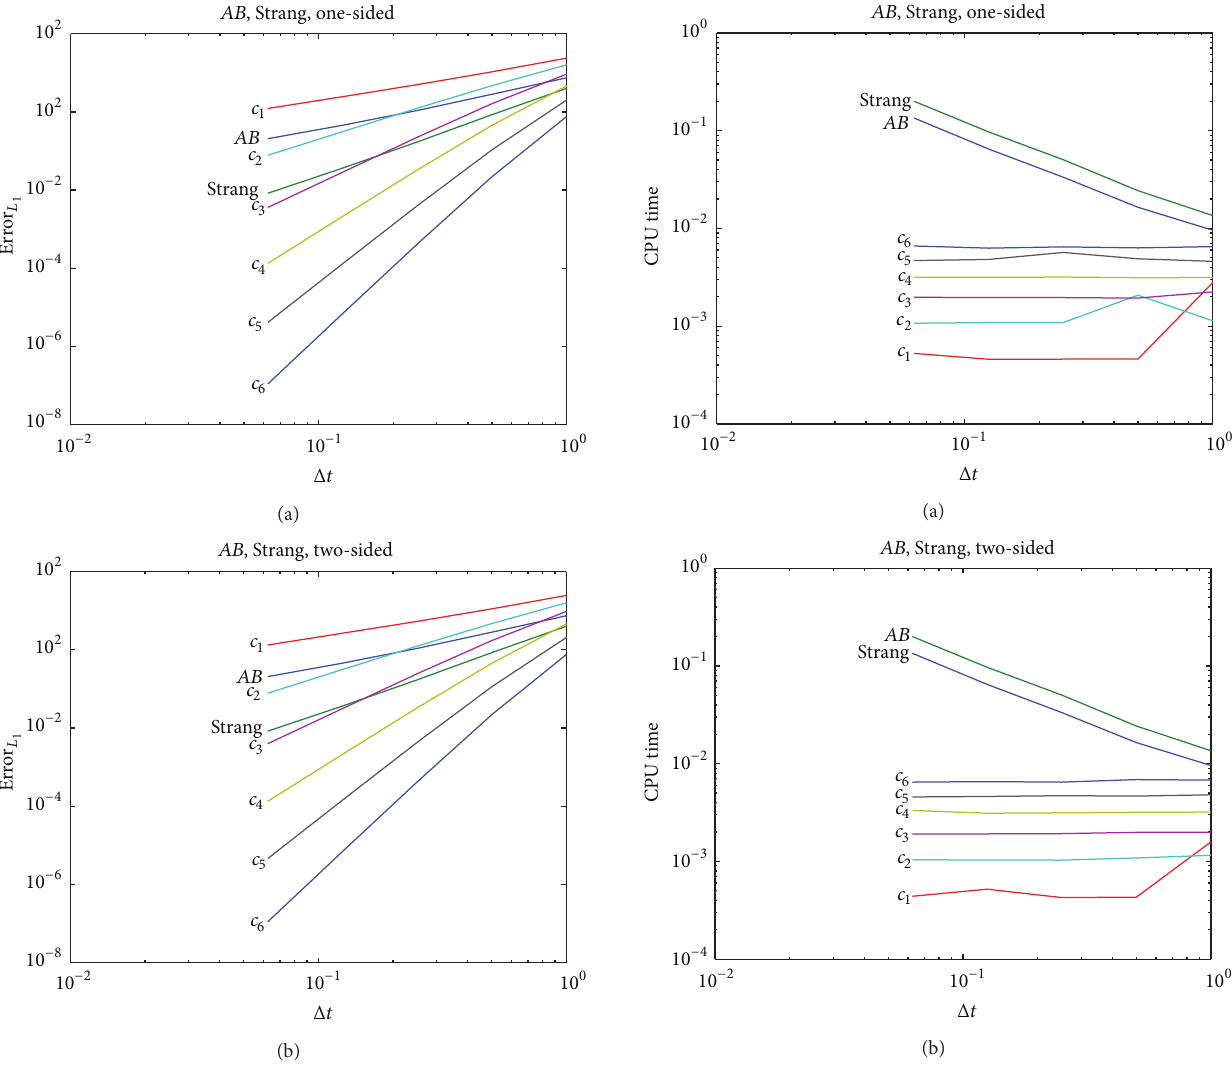
Figure 2: CPU times of the standard splitting scheme and the iterative schemes with the Zassenhaus formula, where we have at least 1,. . . , 4 iterative